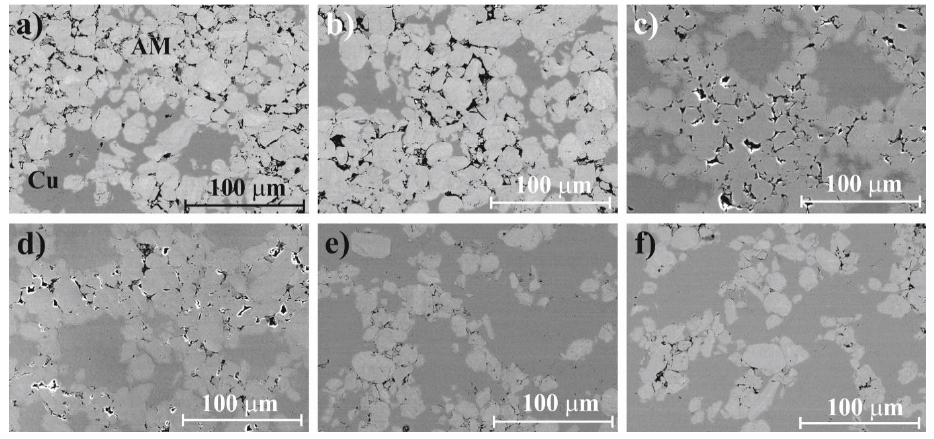
Figure 3. Effect of the copper amount on the microstructure ( a ) MM1; ( b ) MM2; ( c ) MM3; ( d ) BM1; ( e ) BM2; ( f ) BM3.